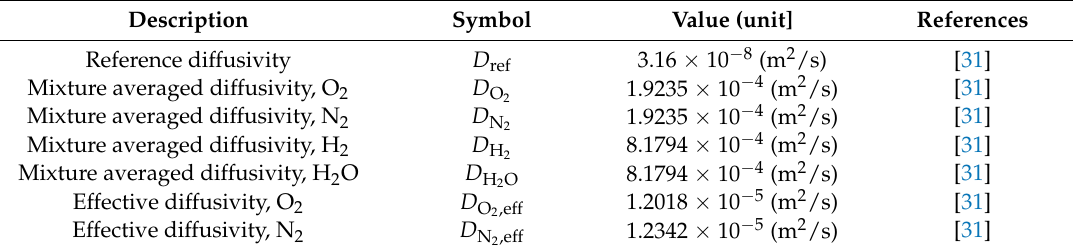
Table 4. Diffusion